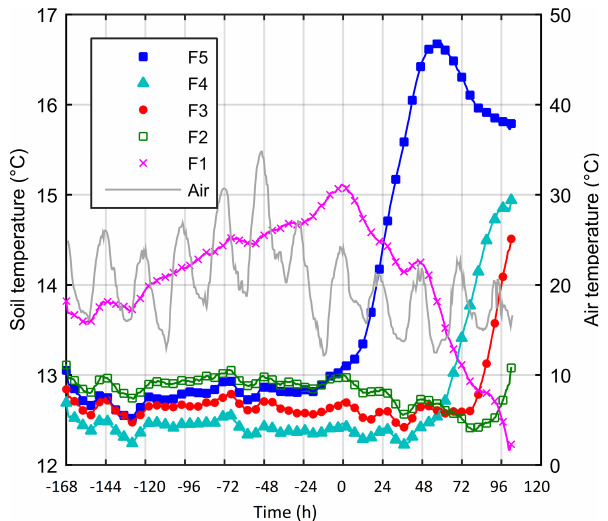
Figure 6. Temperature measured by the distributed temperature sensor at different distances from upstream (F1 to F5) at x = 10m.